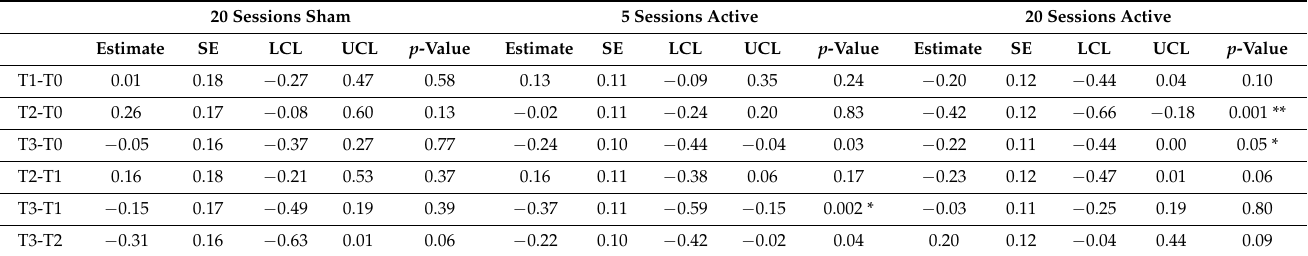
Table 2. Multiple comparison for each time point within each treatment group for the